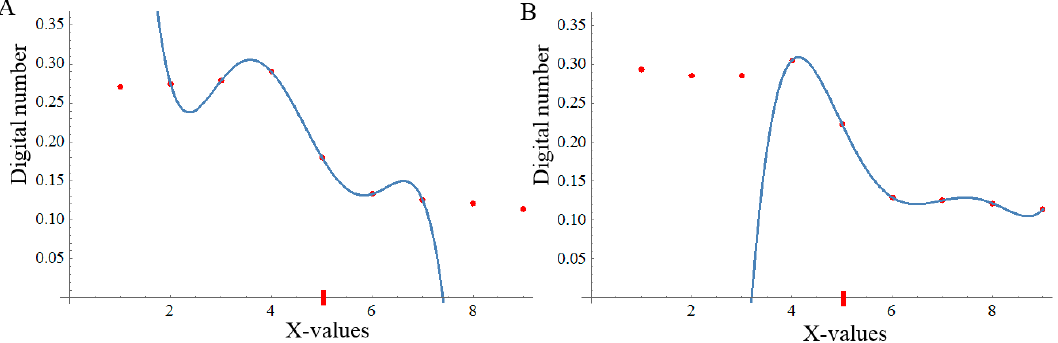
Figure 4. Examples of the adaptive analysis window corresponding to the initial shoreline pixel ( x i , y j ) marked with a white cross and shown over a part of an SWIR1 band-L7 image taken on 14 September 2016. The remaining pixel centres of the rough initial shoreline at pixel level are marked with white dots. This line crosses the analysis window from north to south along the Y -axis. The analysis of divided di ff erences is made on the pixels contained within the discontinuous 9 × 9 white square. The window in ( A ) is composed of a set of 16 pixels (four points each direction) used in a third-degree 2D interpolation, and in ( B ) by 36 pixels (six points each direction) used in a fifth-degree 2D interpolation. The selected set of pixels along the Y -axis and X -axis is bounded in blue and orange, respectively.